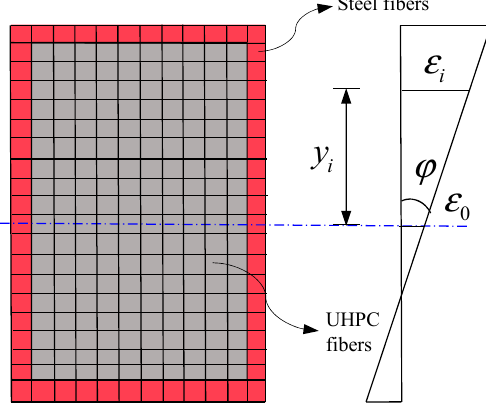
Figure 2. Fiber model cross-section.